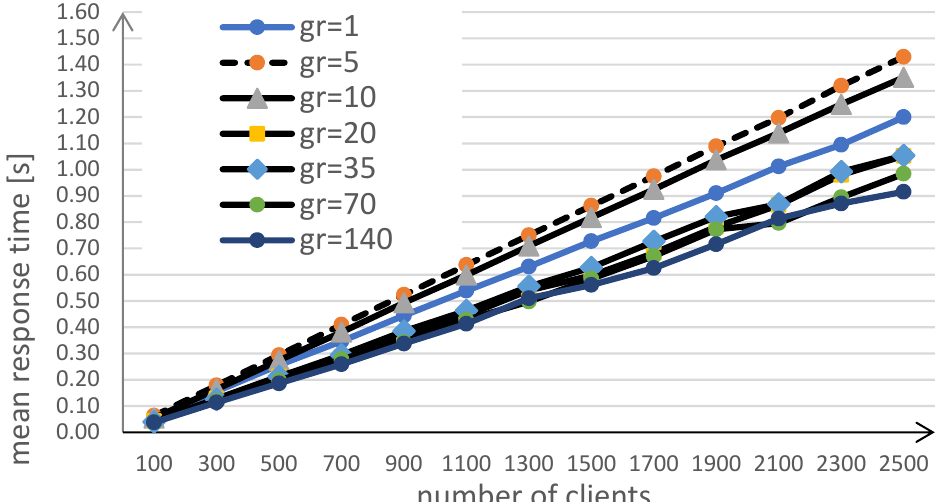
11 of 19 Figure 8. Division into groups with a balanced number of requests.